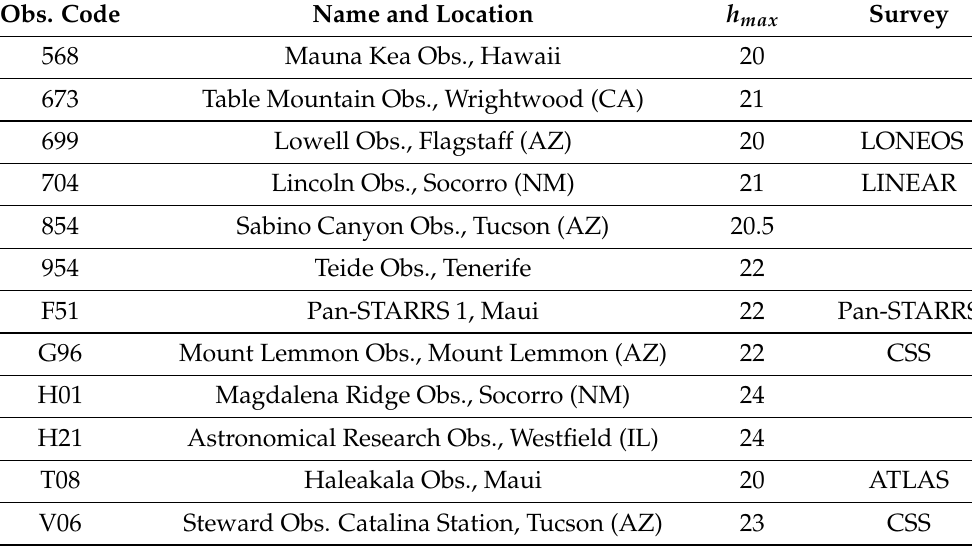
Table 2. List of the observatory codes and respective limiting magnitudes used in this work. Obs. Code